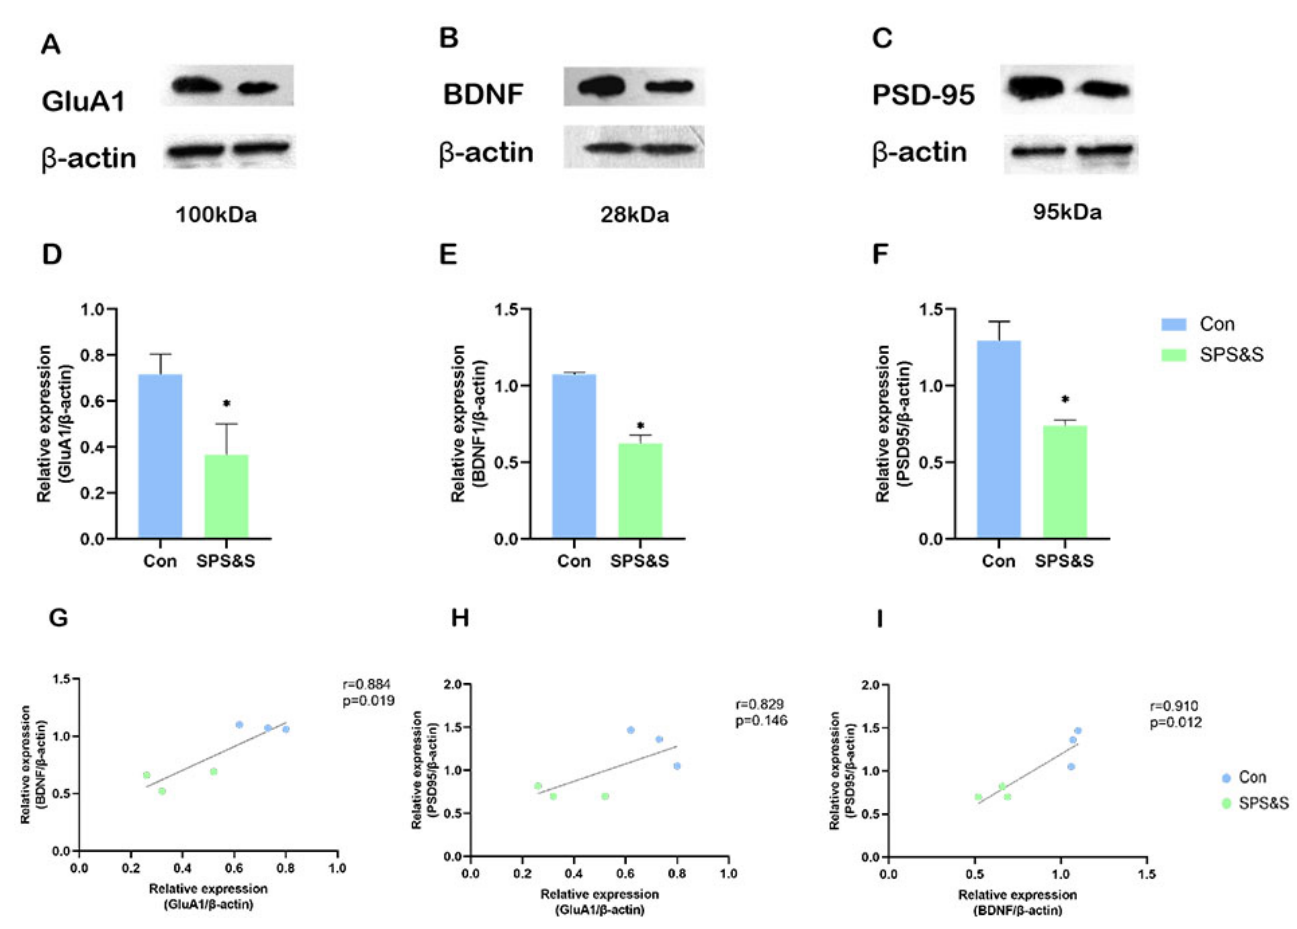
Figure 3. Effects of SPS&S on the GluA1, BDNF, and PSD-95 protein levels in the mPFC. The representative blots for GluA1 ( A ), BDNF ( B ), and PSD-95 ( C ); GluA1 ( D ), BDNF ( E ), and PSD-95 ( F ) protein levels measured by Western blot analysis. ( G – I ) show the correlation between different proteins. Data are represented as mean ± SEM. * p < 0.05.